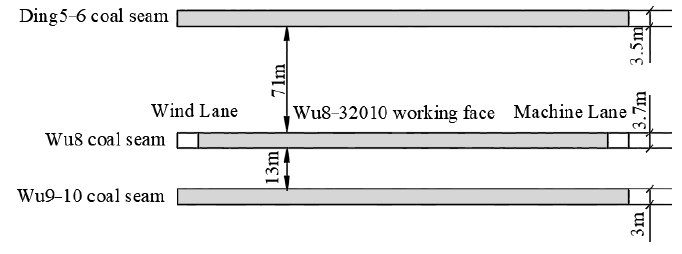
Figure 1. Wu8 − 32010 working face strike